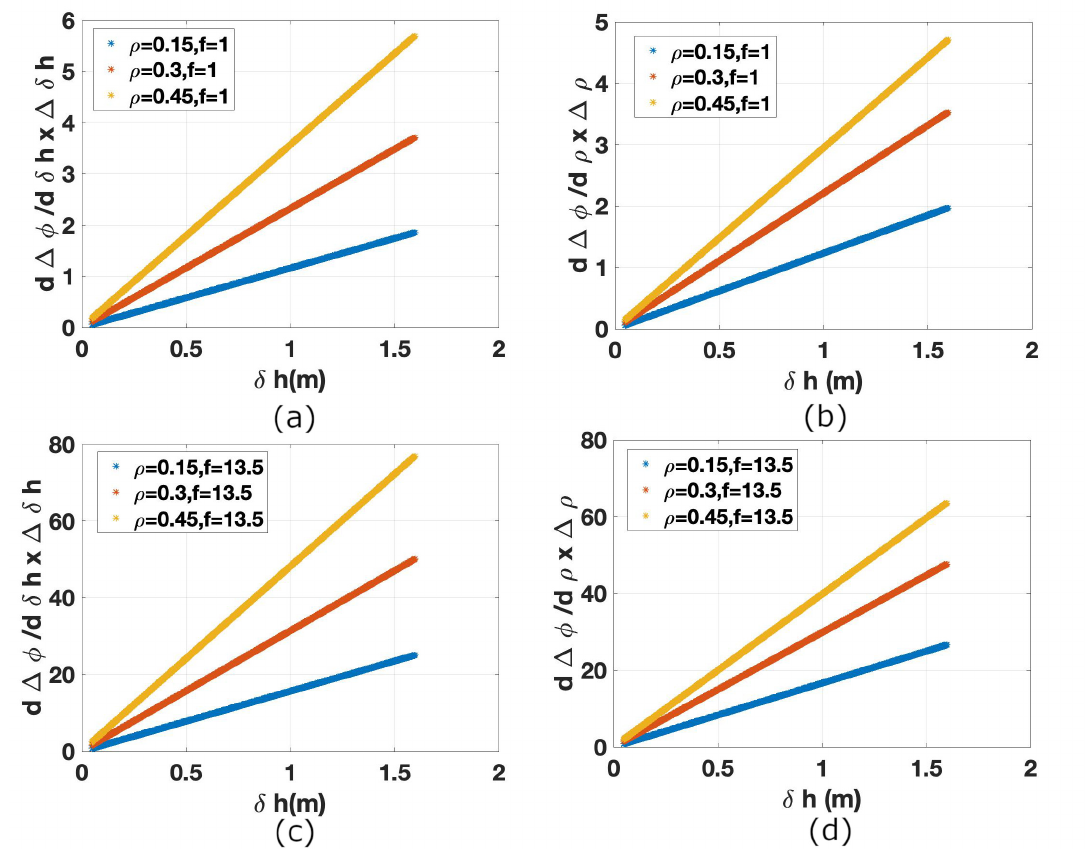
Figure 9. ∆ φ variation vs. δ h with variation of ( a ) δ h and ( b ) snow density at 1 GHz. ∆ φ variation vs. δ h with variation of ( c ) δ h and ( d ) snow density at 13.5